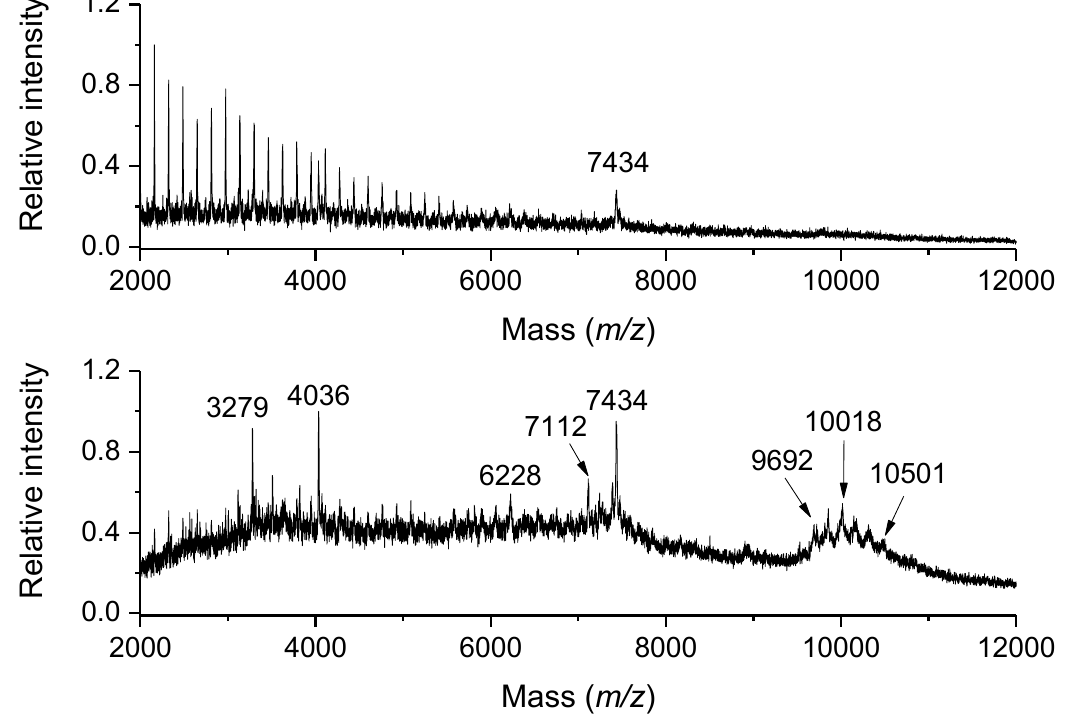
Figure 4. MALDI-TOF MS of beer. This sample of a non-pasteurized Czech lager beer was measured using an ultrafleXtreme instrument (Bruker Daltonics). The depicted mass spectra were acquired in the linear positive ion mode with a stainless-steel target and DHB as a matrix according to Šedo et al. [82]. The top panel shows a series of maltooligosacharides ( m/z 2160–7365, sodium adduct peaks, with a regular mass difference of 162 units) and was acquired from the central part of the sample spot. The bottom spectrum shows signals of beer proteins. It was acquired from the rim of the sample spot. Interestingly, the signal cluster between m/z 9692 and 10,501 refers to the non-specific lipid transfer protein 1 (LTP1) from barley and its glycated forms [81]. The content is author´s own work.